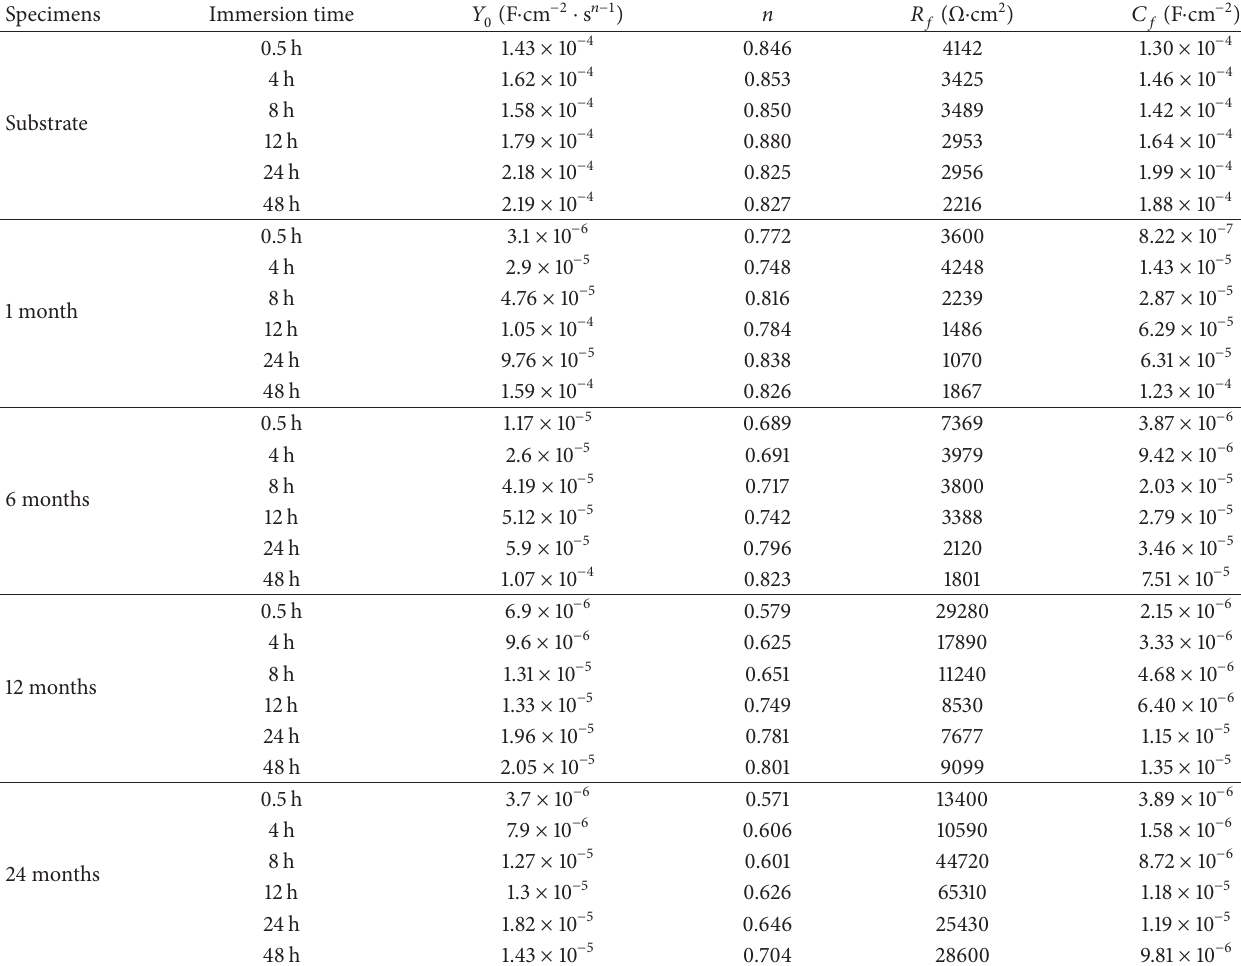
Table 4: Values of the parameters 𝑌 0 , 𝑅 𝑓 , and 𝑛 as well as the calculated 𝐶 𝑓